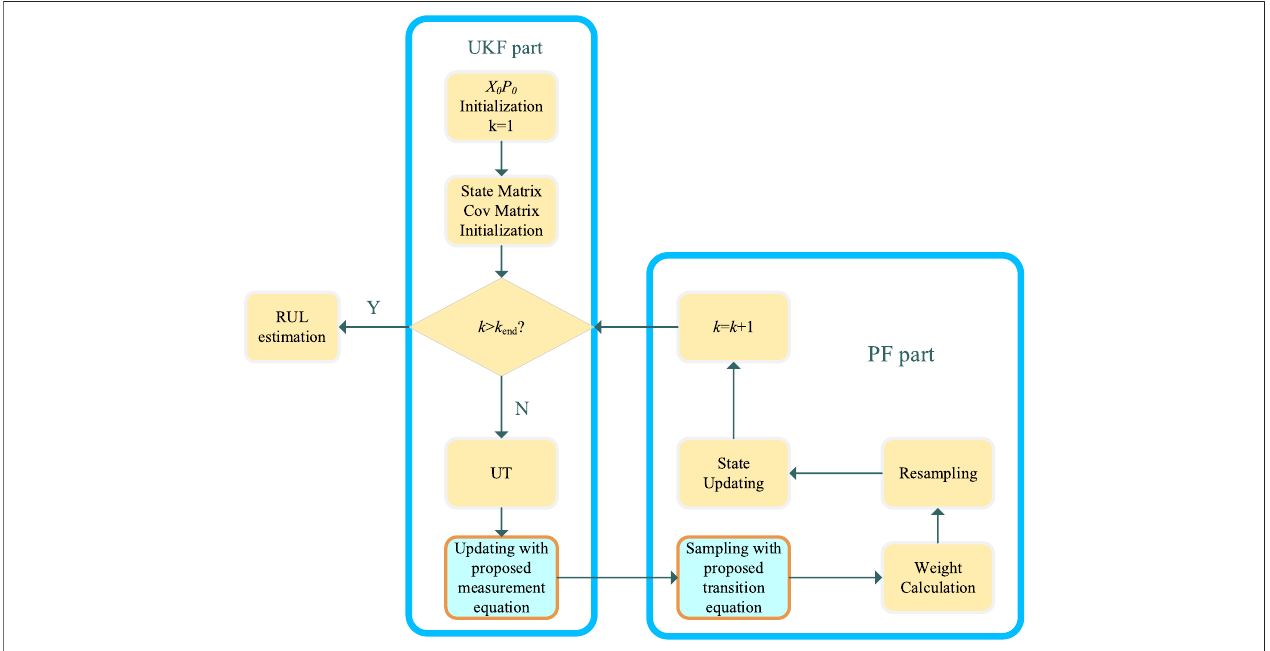
FIGURE 6 | Prediction method based on Improved UPF